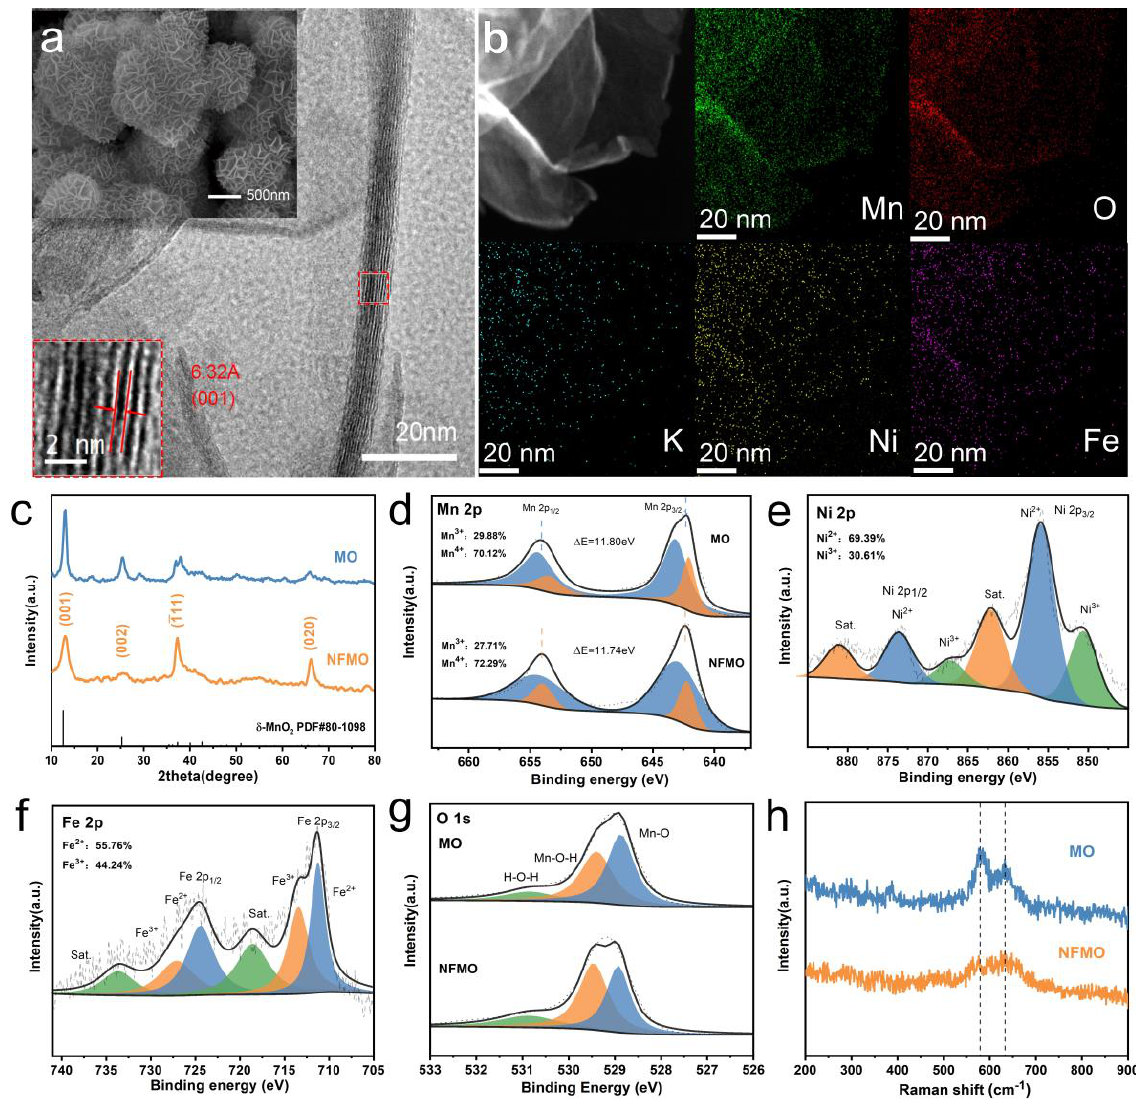
Figure 2. ( a ) SEM, TEM and HRTEM images of NFMO. ( b ) EDS elemental mapping of the NFMO sample. ( c ) XRD patterns of NFMO and MO. ( d – g ) XPS characterization of NFMO and MO: ( d ) Mn 2p spectrum, ( e ) Ni 2p spectrum, ( f ) Fe 2p spectrum, ( g ) O 1s spectrum. ( h ) Raman spectrum.